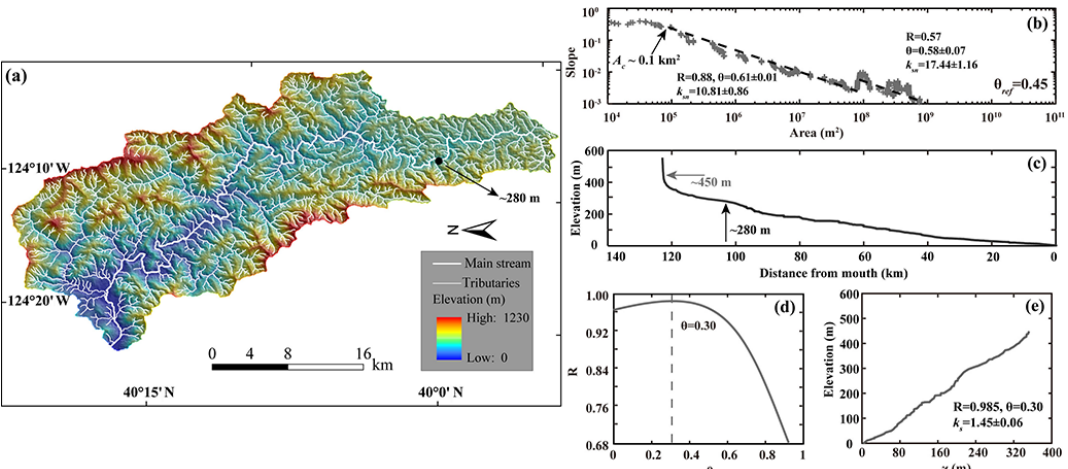
Figure 17. The slope–area data and χ − z plot of the stem of Mattole river. (a) Map of the stem and its tributaries in the Mattole drainage basin. Elevation data are from 1 / 3arcsec USGS DEM (downloaded from https://catalog.data.gov/dataset/national-elevation-dataset). (b) The log-transformed slope–area plot of the stem (a 300m smoothing window and 20m contour sampling interval). A knickpoint is detected from the plot with variant k sn along the channel. (c) River profile of the stem. The gray arrow indicates the dividing point ( ∼ 450m) between the colluvial and fluvial portions. The black arrow shows the knickpoint ( ∼ 280m) on the stem. (d) The correlation coefficients between elevation and χ values as a function of θ . The maximum value of R , which corresponds to the best linear fit, occurs at θ = 0.30 (gray dashed line). (e) The χ − z plot of the stem, transformed according to Eq. (3) with θ = 0.30, A cr = 0.1km 2 , and A 0 = 1m 2